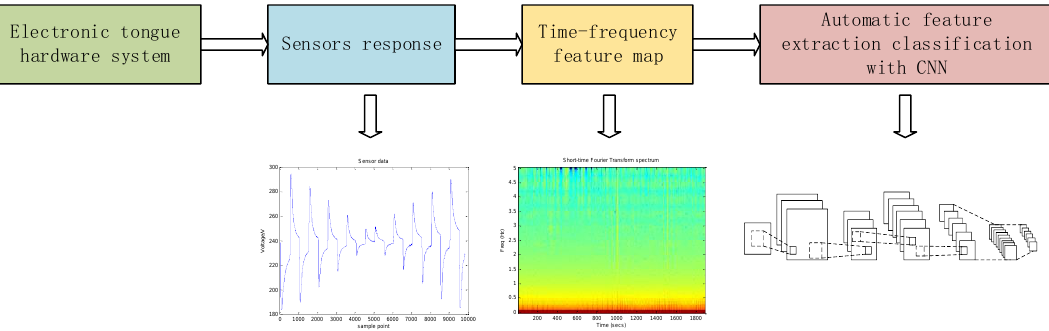
Figure 2. The overview processing of convolutional neural network (CNN) based auto features extraction strategy.